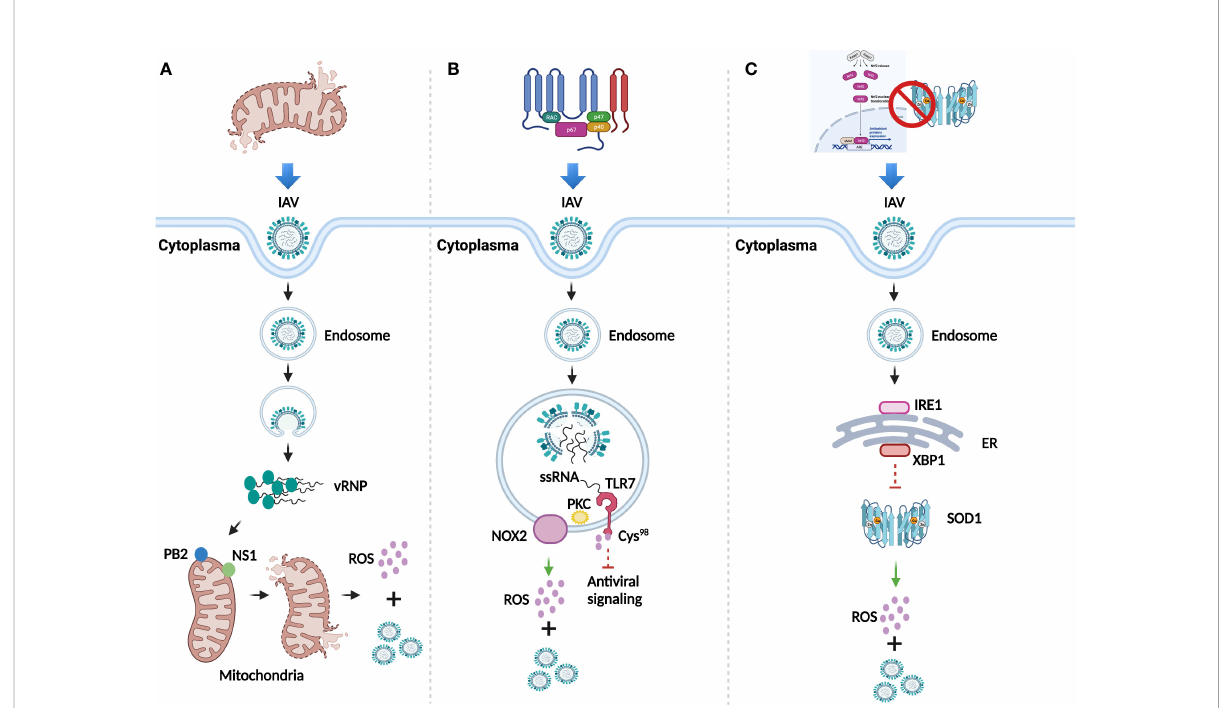
FIGURE 1 ROS generation after IAV infection. (A) Dysfunction of mitochondria mediated by IAV infection for the generation of ROS and viral replication. (B) ROS generation and viral replication mediated by activation of NADPH oxidase. (C) Inhibition of antioxidant signaling pathway and antioxidant enzymes for ROS generation and viral